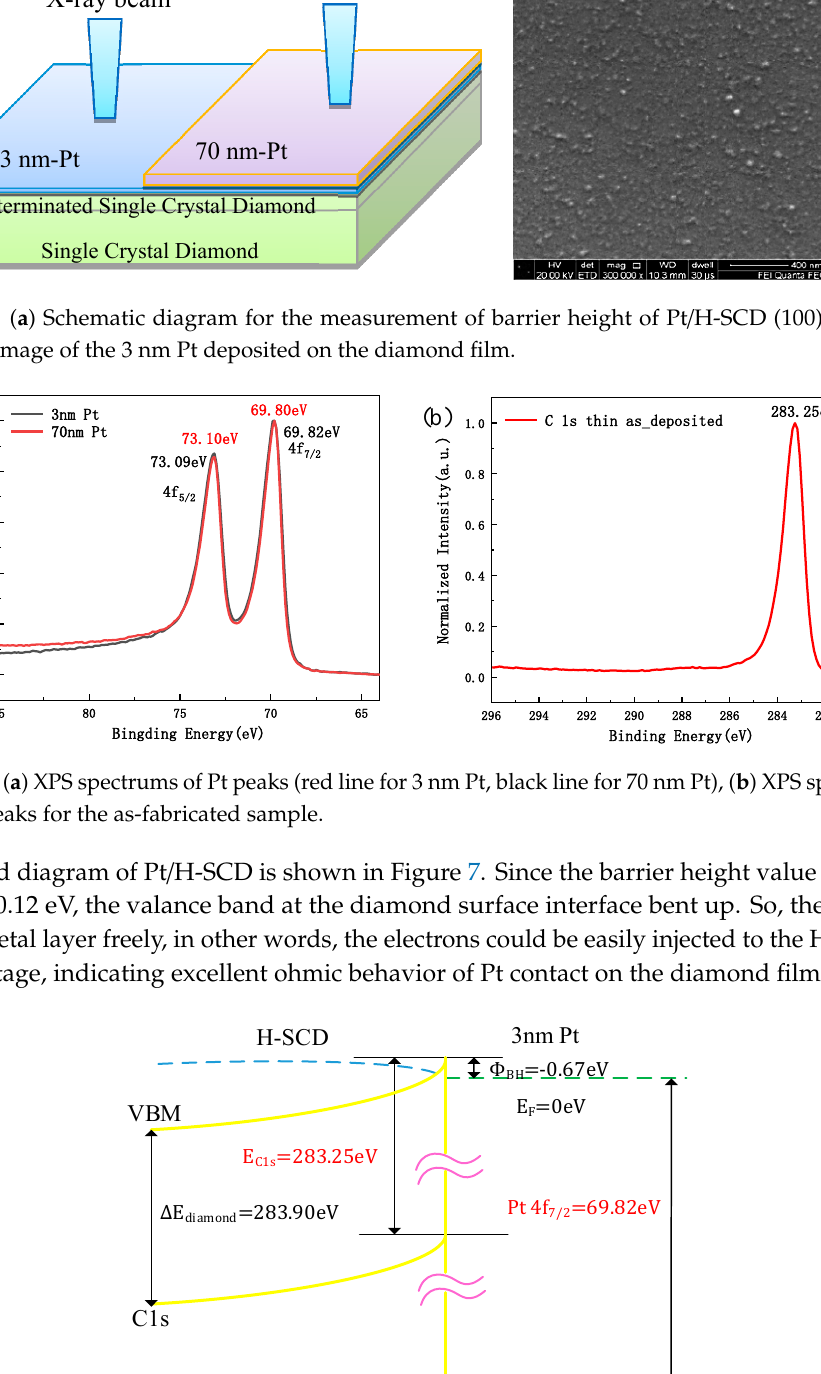
Figure 7. Schematic of band diagram for Pt/H-SCD contact.